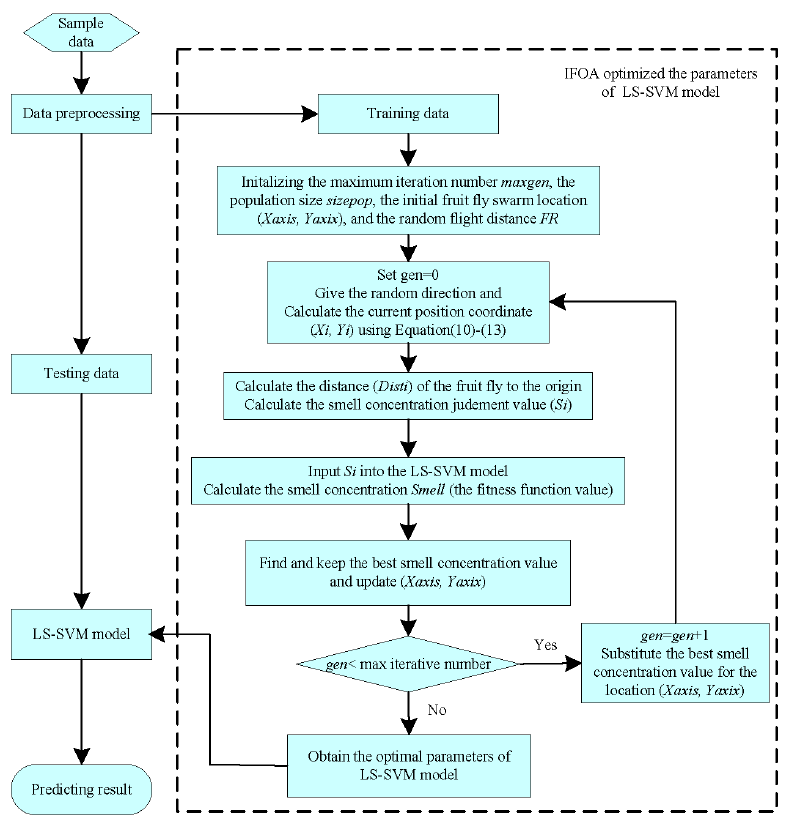
Figure 10. Procedure diagram of the least squares support vector machine the improved based on fruit fly optimization algorithm (IFOA-LS-SVM) model.